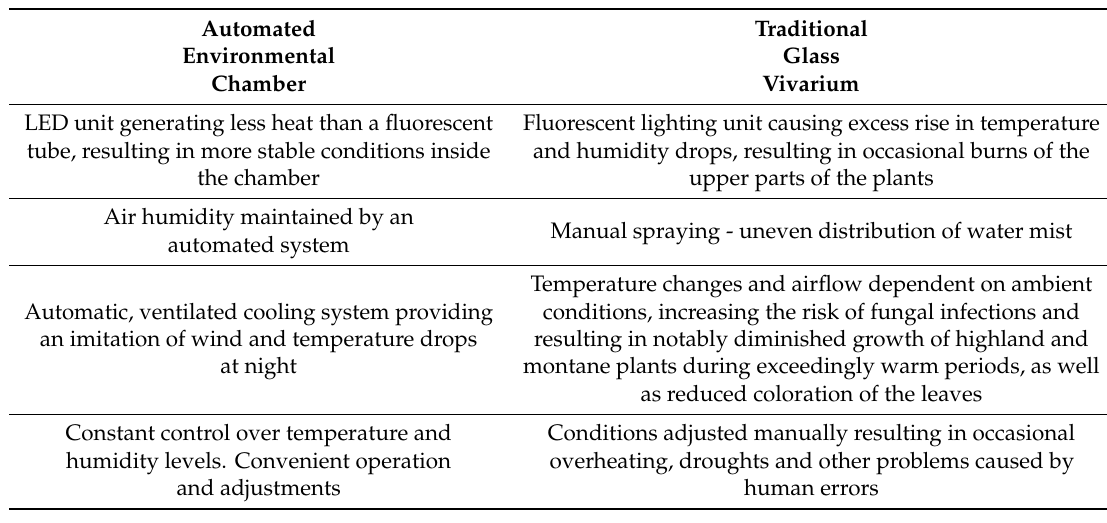
Table 2. Observation results: growing plants in an automated chamber compared to specimens kept in a manually maintained glass